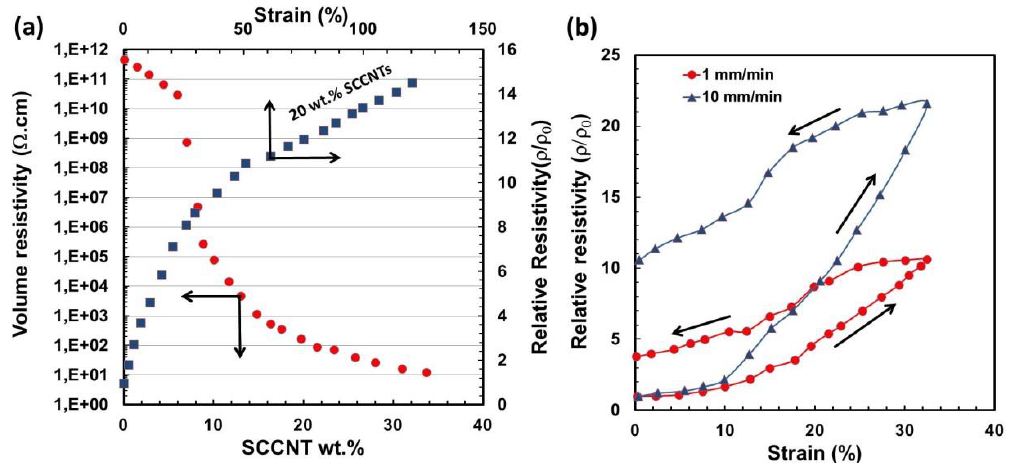
Figure 9. ( a ) Volume resistivity as a function of SCCNT concentration and relative resistivity changes as a function of percent strain and ( b ) effect of stain rate on the relative resistivity for 20 wt % SCCNT containing biocomposite. All data were acquired after impregnation into the cellulose network. Sensitivity of the relative resistivity ( / 0 ) of the conductive papers (20 wt % SCCNT) to strain